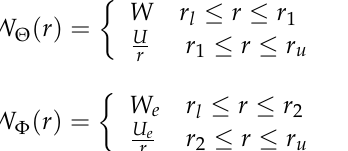
≤ r ≤ r < r < r 2 2 ; ( b ) r 2 1 ; ( a ) r 1 ; and ( c ) r